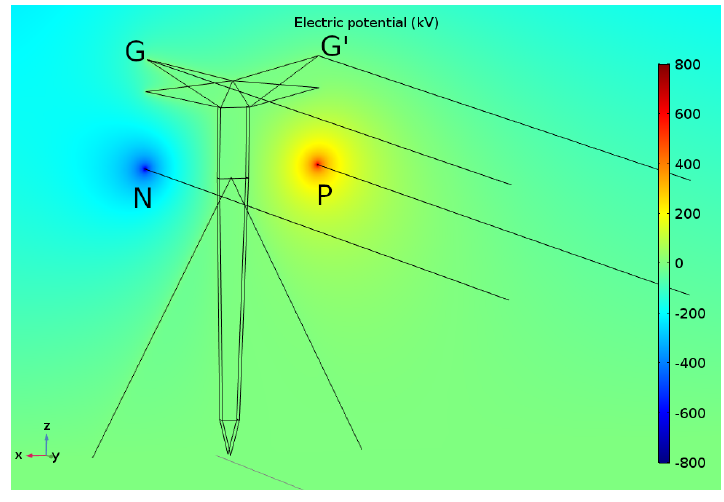
Figure 6. Electric Potential.